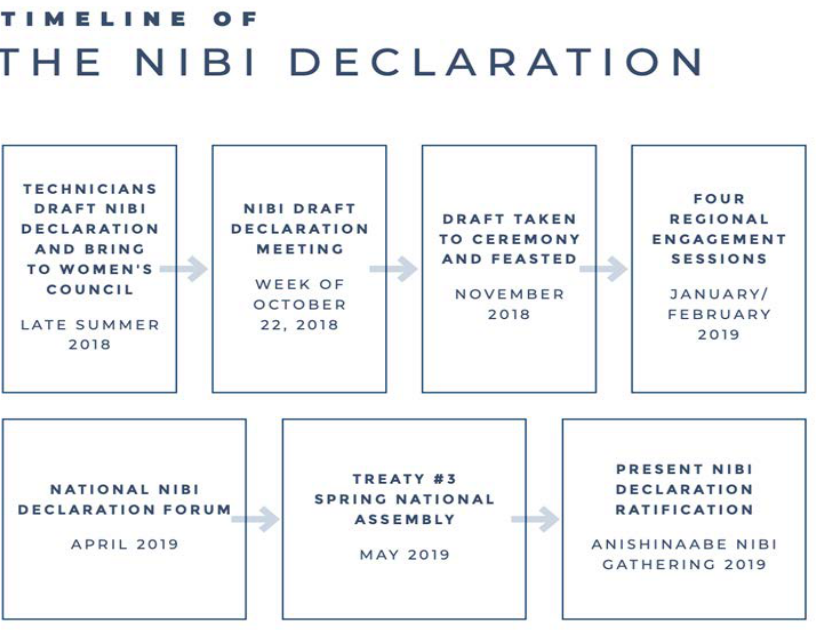
Figure 3. Timeline of the Nibi Declaration [2]. Copyright 2020 NIBI. Technicians and members of The Women’s Council facilitated sessions across the four regions of the Territory (Kenora (twice), Dryden, and Fort Frances). In each session, regional particularities (language, teachings, songs, etc.) were identified. An important piece of the regional diversity feedback was on the terms used to refer to water and types of water. Since language is central to Anishinaabe ways of knowing, the connection to oneself and teachings on how to live a good life [16,17], a decision was made to use the common term in Anishinaabemowin—Nibi—to reflect all forms of